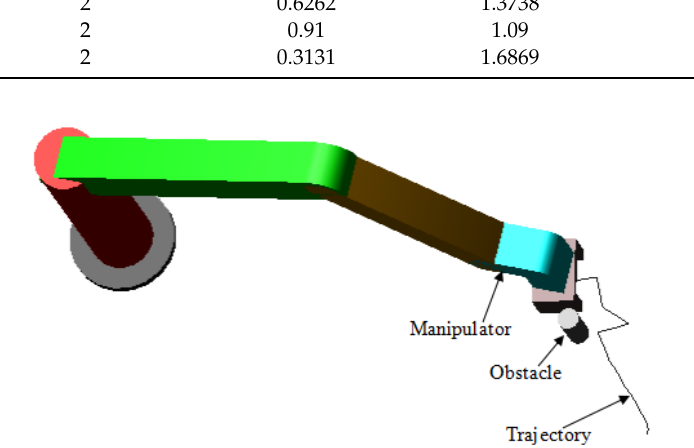
Figure 16. End state of the pickup manipulator.